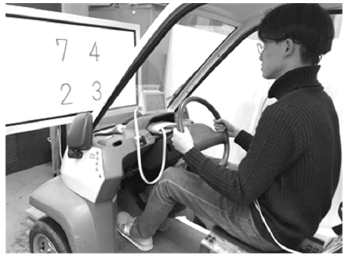
Figure 7. Experimental setup.